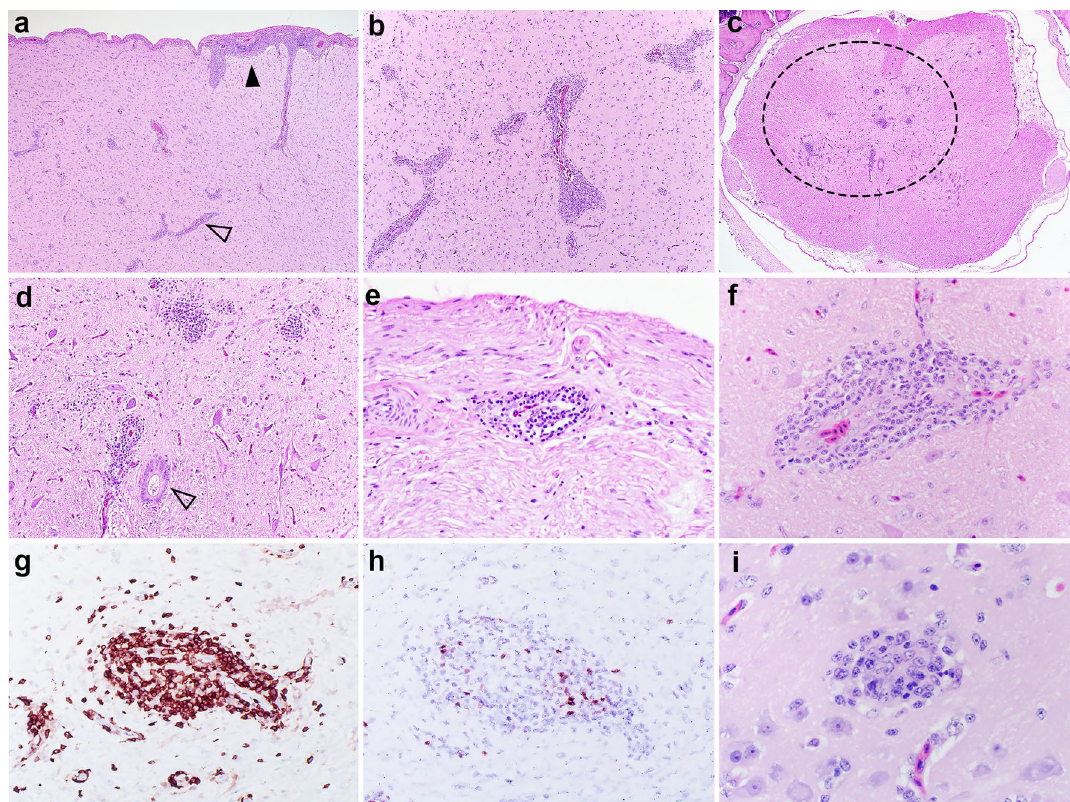
Figure 3. Histology of representative lesions in the nervous tissue of Muscovy ducks experimentally infected with aquatic bird bornavirus 1 (ABBV-1). ( a ) Cerebrum, duck #519 IC group, sampled at 4 weeks post infection (wpi). The leptomeninges (black arrowhead) and Virchow-Robin spaces (empty arrowhead) are segmentally and multifocally expanded by an inflammatory infiltrate. HE, original magnification 100X. ( b ) Cerebrum, duck #519 IC group, 4 wpi. The perivascular spaces are expanded by a severe mononuclear inflammatory infiltrate. HE, original magnification 40X. ( c , d ) Spinal cord, duck #612 IM group, 8 wpi. Mainly affecting the grey matter (circle), there are multifocal areas of inflammation composed of mononuclear cells. Empty arrowhead indicates the central canal. HE, original magnification 40X ( c ) and 100X ( d ). ( e ) Peripheral nerve (ischiatic or axillary), duck #621 IM group, 8 wpi. There are scattered inflammatory perivascular cuffs in the endoneurium of affected nerves. HE, original magnification 200X. ( f ) Cerebrum, duck #502 IC group, 12 wpi. The perivascular cuffs are composed of mononuclear cells, predominately lymphocytes with scattered plasma cells. HE, original magnification 400X. ( g , h ). Optic lobe, duck #502 Immunohistochemistry for CD3 ( g ) and Pax-5 ( h ) antigens on consecutive sections. The large majority of inflammatory cells displays strong cytoplasmic reactivity for CD3 antigen (T lymphocytes); while scattered cells display intranuclear reactivity for Pax-5 (B lymphocytes). Reactivity for CD3 clearly shows spilling of T lymphocytes from the perivascular cuffs into the adjacent neuroparenchyma. IHC, DAB chromogen with hematoxylin counterstain, original magnification 200X. ( i ) Cerebrum, duck #534 IC group, 4 wpi. There are rare, randomly distributed, accumulations of glial cells arranged in small clusters (glial nodules). These cells are round with moderate amounts of eosinophilic cytoplasm and open chromatin. HE, original magnification